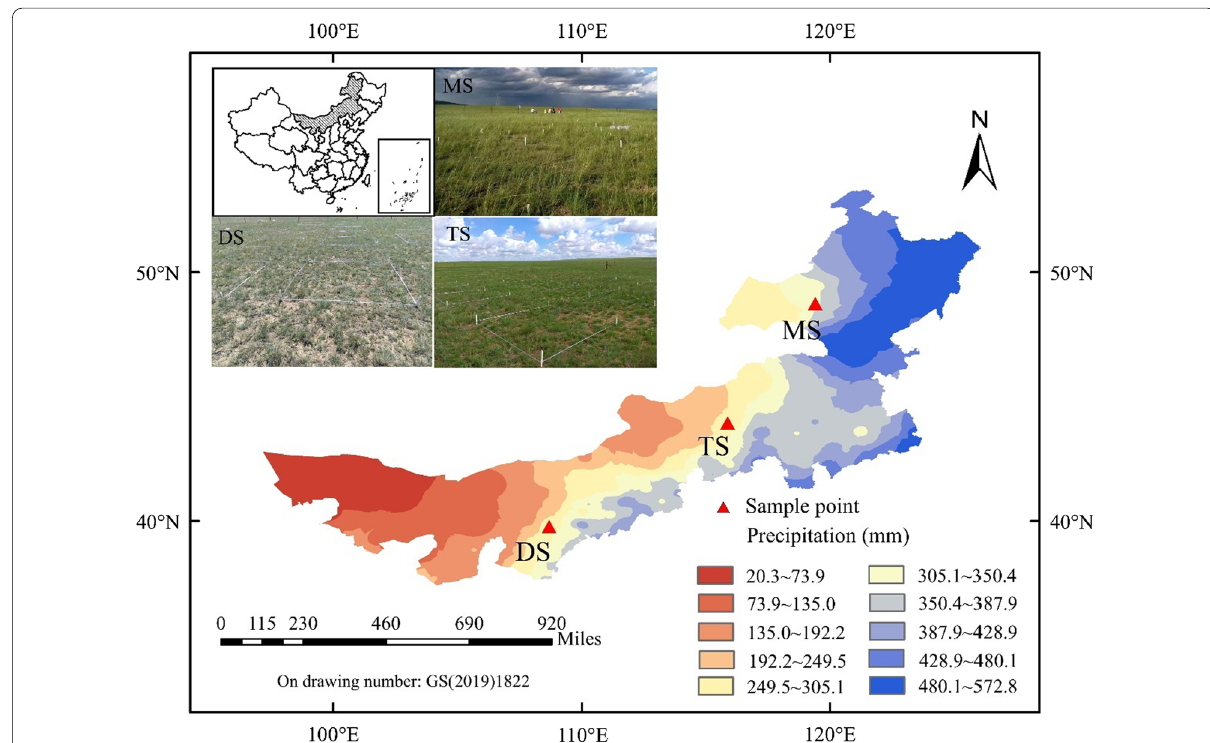
Fig. 1 Locations and landscapes of the three steppe types in Inner Mongolia. MS, TS and DS represent meadow steppe, typical steppe and desert steppe,